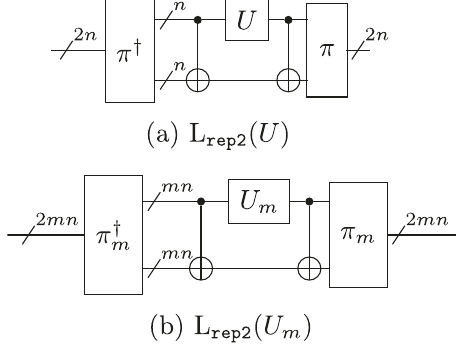
Fig. 2 Logical operators for C Stab ; REP2 . Given single-qubit and multi- qubit logical operators of C Stab denoted by U and U m , respectively, we obtain corresponding logical operators for C Stab ; REP 2 in a and b , respectively. The permutation π m maps the j th qubit in the fi rst